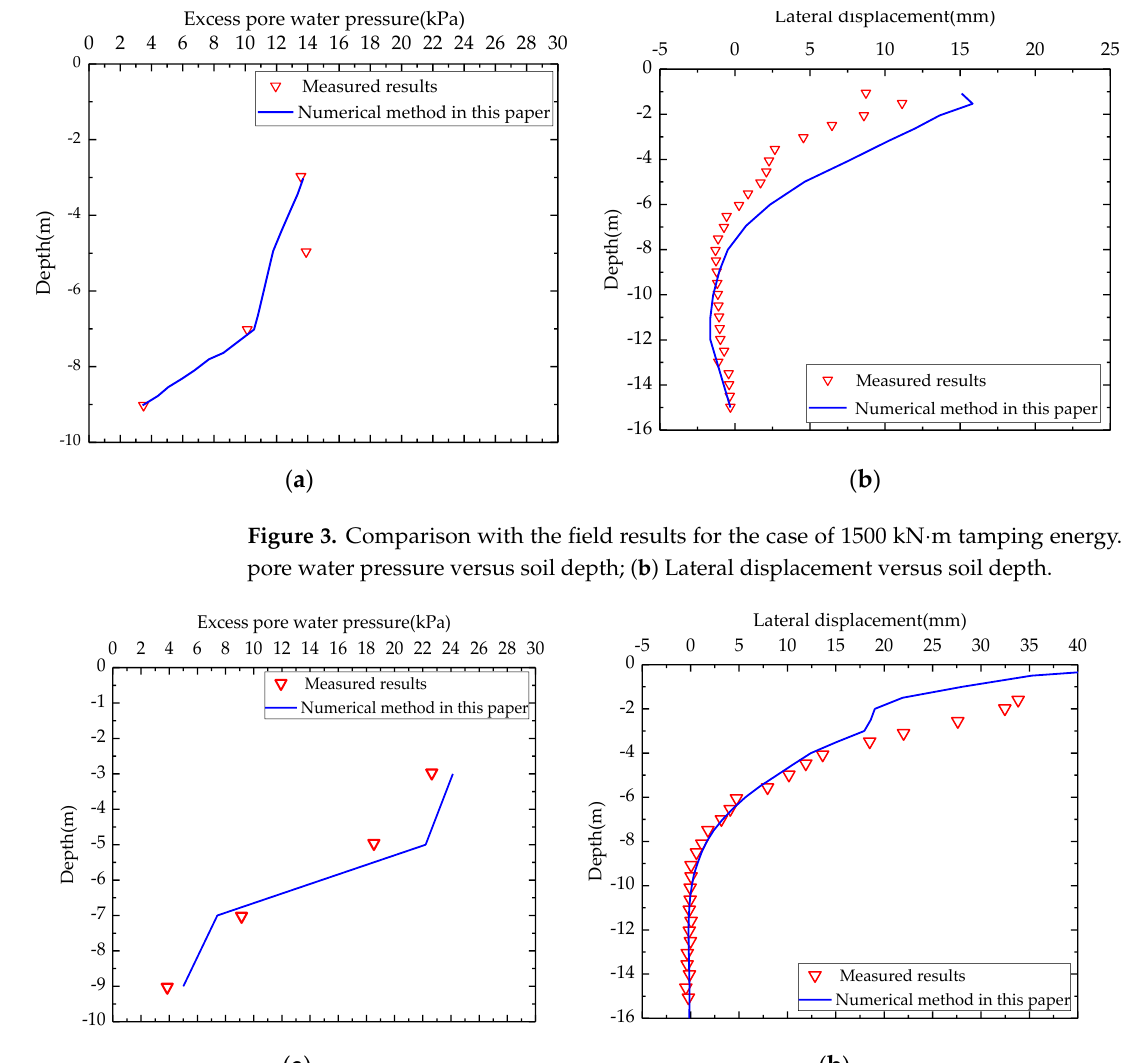
Figure 2. Excess pore water pressure versus time. ( a ) 1500 kN·m; ( b ) 2500 kN·m [17].